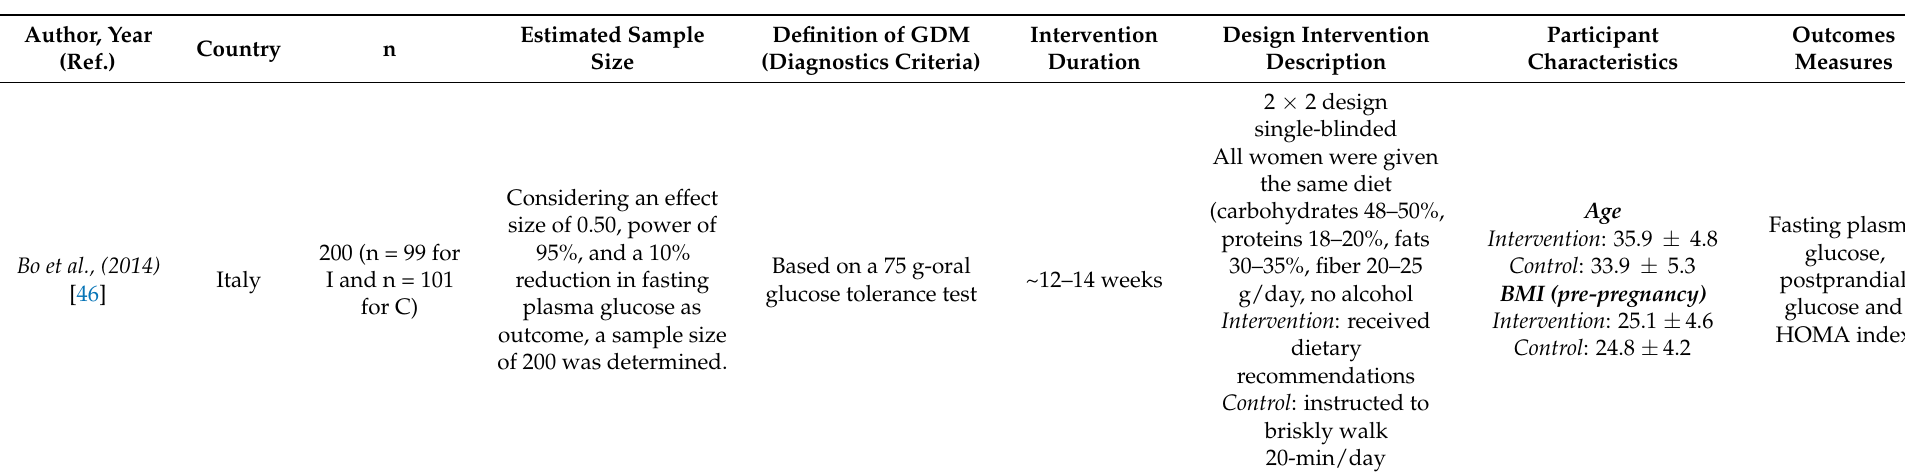
Table 3. Summary of RCTs investigating effect of exercise-based interventions on glycemic indices in